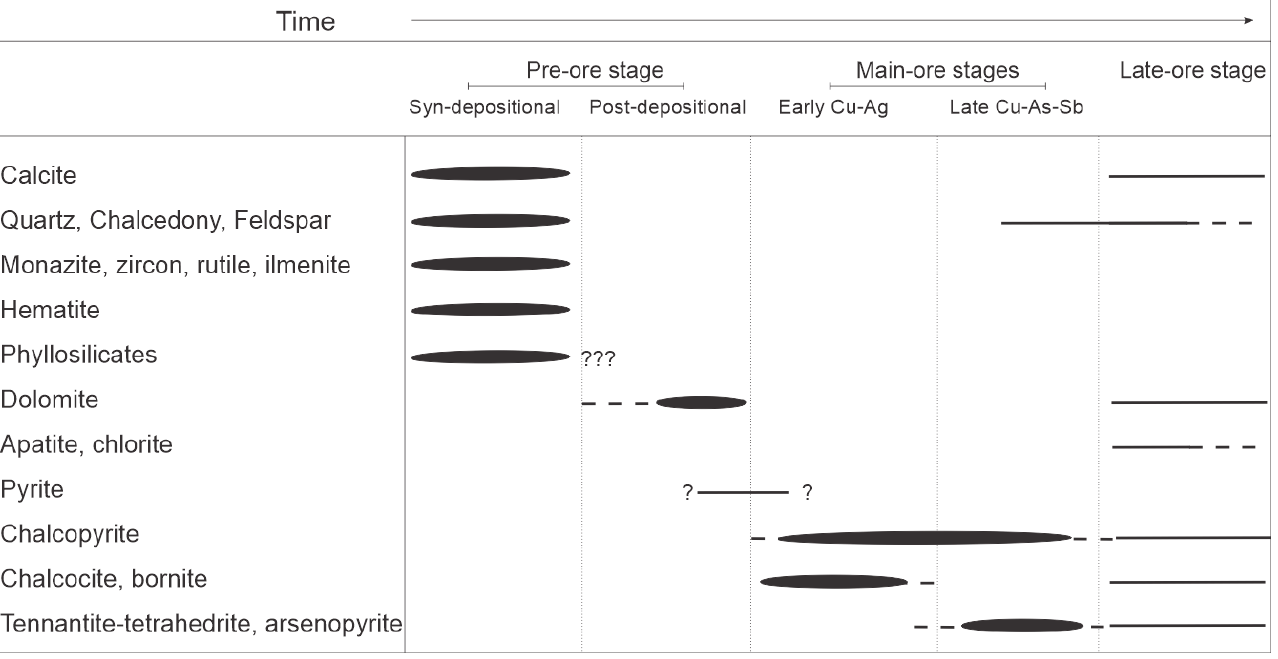
Figure 11. Proposed paragenetic sequence of the Tullacondra deposit.